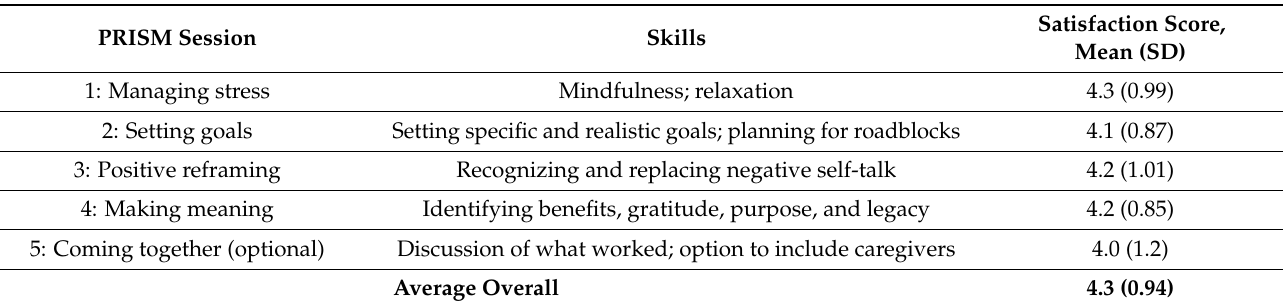
Table 3. Satisfaction with PRISM among youth with CMP ( n =